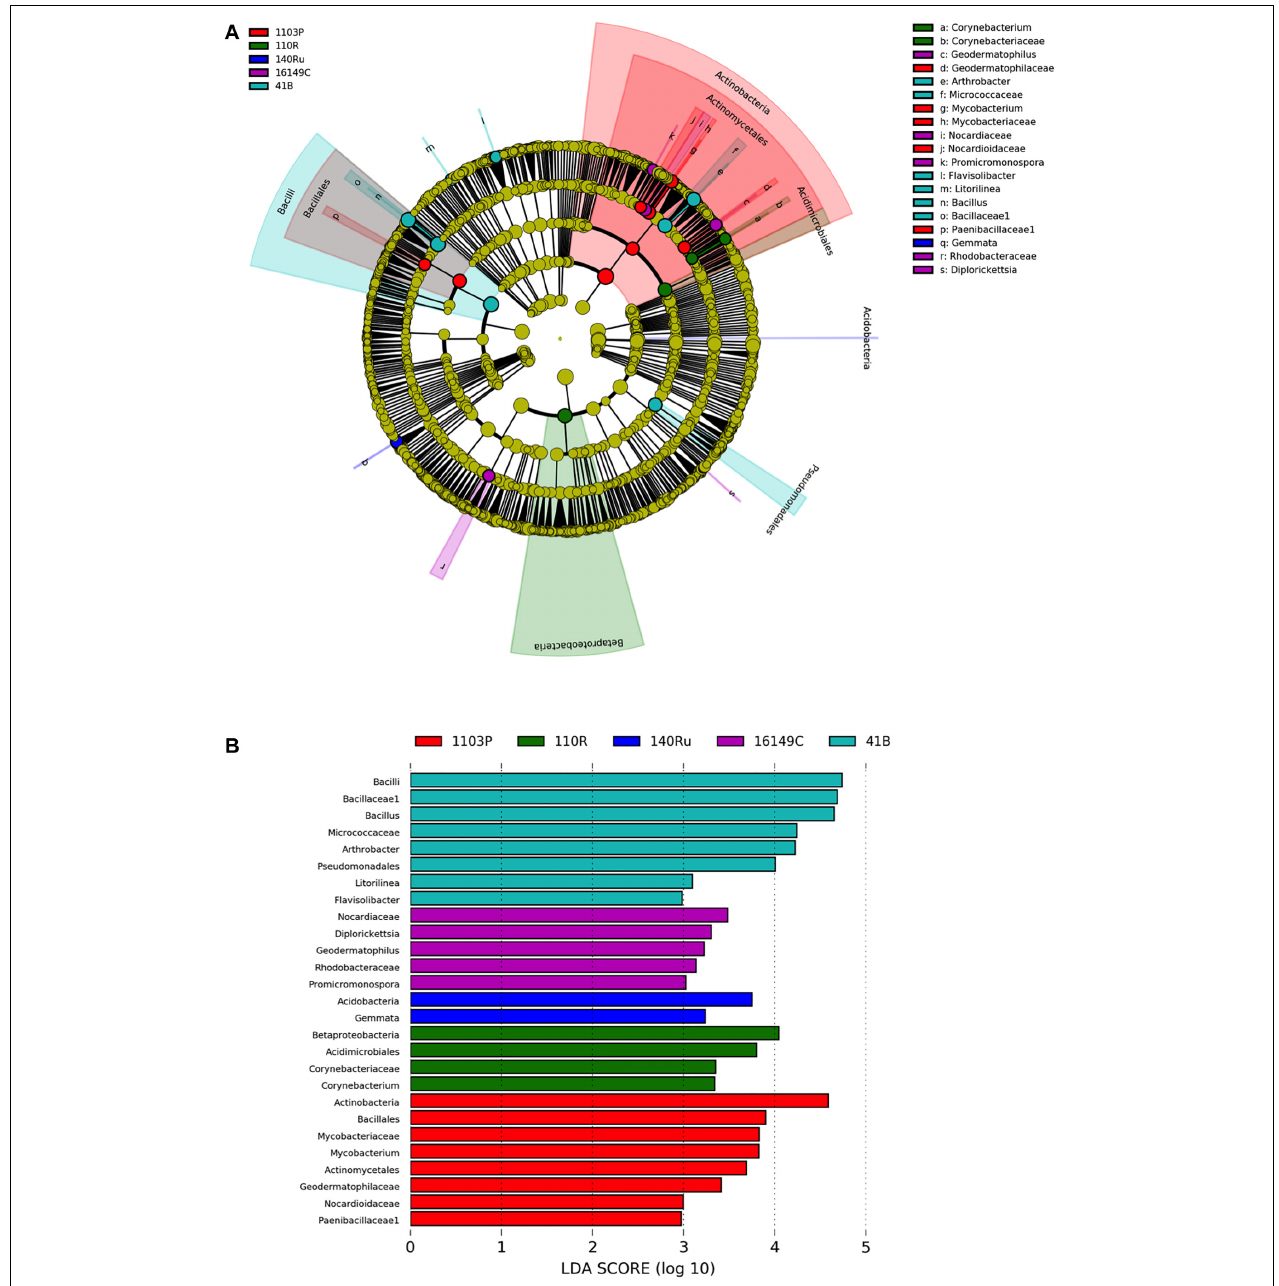
FIGURE 3 | LEfSe was used to identify the most differentially abundant taxa among grapevine rootstocks in Aldea vineyard. Cladogram generated by LEfSe indicating differences of bacteria (A) at phylum, class, family, and genus levels between the five groups (relative abundance ≤ 0.5%). Each successive circle represents a phylogenetic level. Color regions indicate taxa enriched in the different rootstocks. Differing taxa are listed on the right side of the cladogram. Bar graph showing LDA scores for bacteria (B) . Only taxa meeting an LDA significant threshold > 2 are